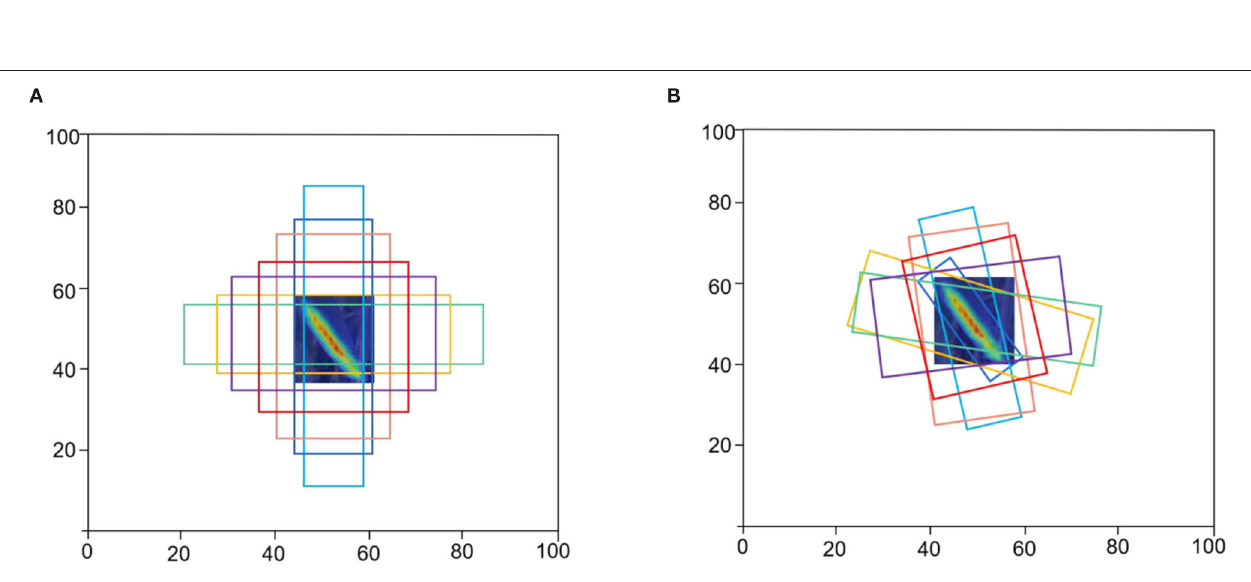
anchors ( Figure 7B ) are used for regression to obtain more accurate